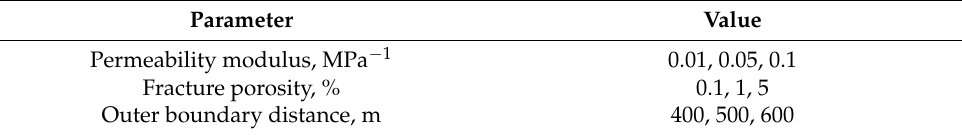
Table 2. Range of values for sensitive